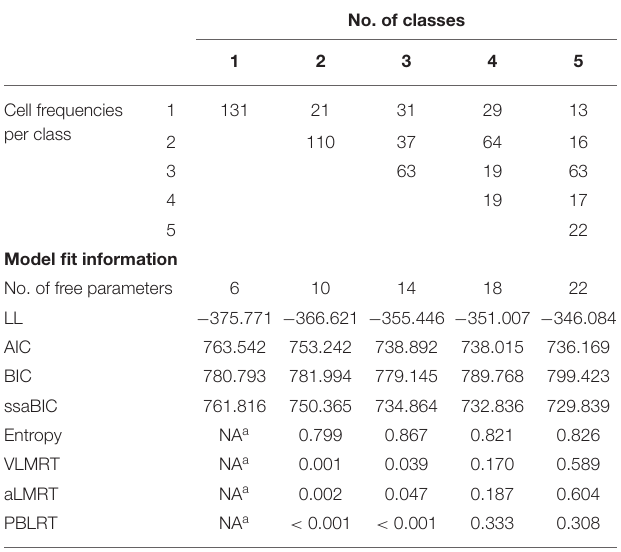
TABLE 3 | Cluster identification and model fit information.